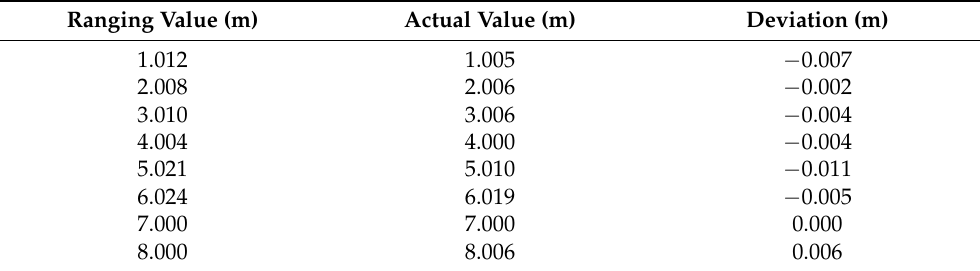
Table 2. Experiment results of the ranging accuracy. Ranging Value (m) Actual Value (m) Deviation